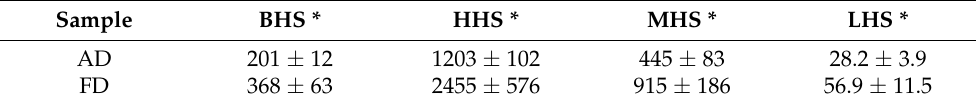
Table 2. DOC concentrations (mg-C/L) of extracted size-fractioned HS in AD and FD samples.